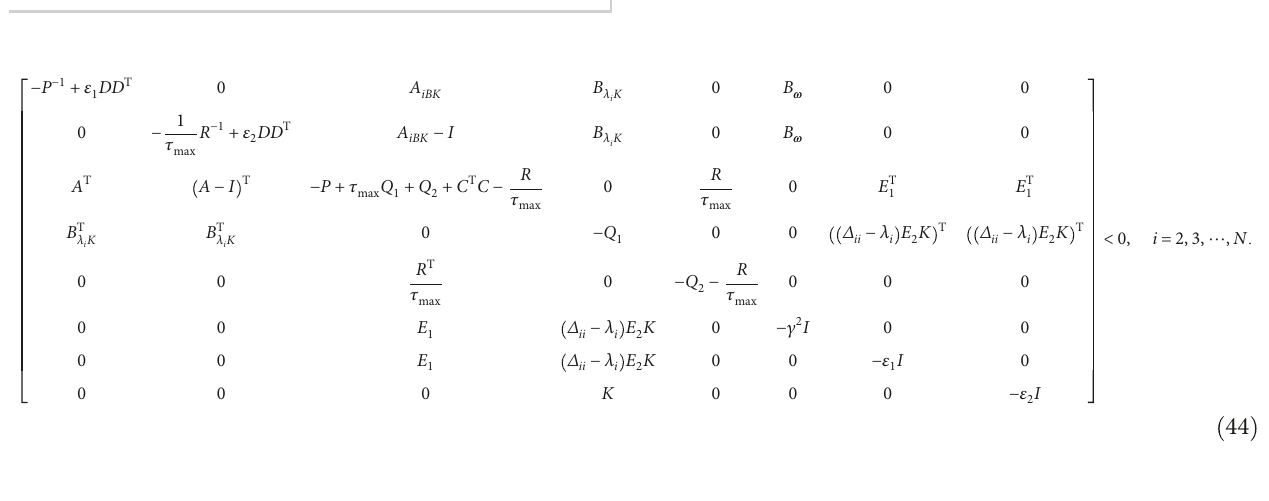
Algorithm 1: A possible way to the optimization problem (37) –